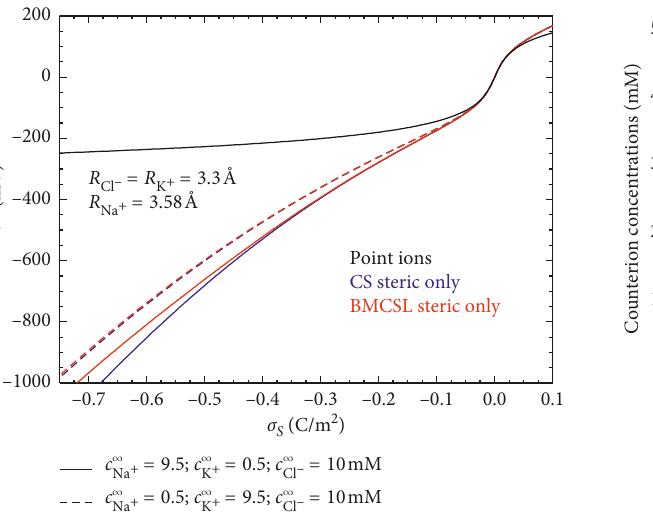
Figure 6: Dependence of the electric potential drop across the diffuse electric double layer on the surface charge density calculated using the CS and BMCSL steric interaction only models and mixed aqueous NaCl and KCl solutions with the indicated parameters.